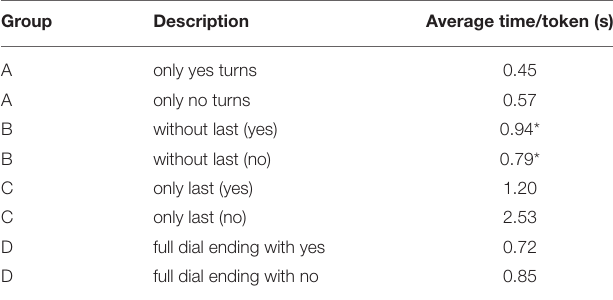
TABLE 6 | Average time (seconds) taken by humans to solve games belonging to the different groups